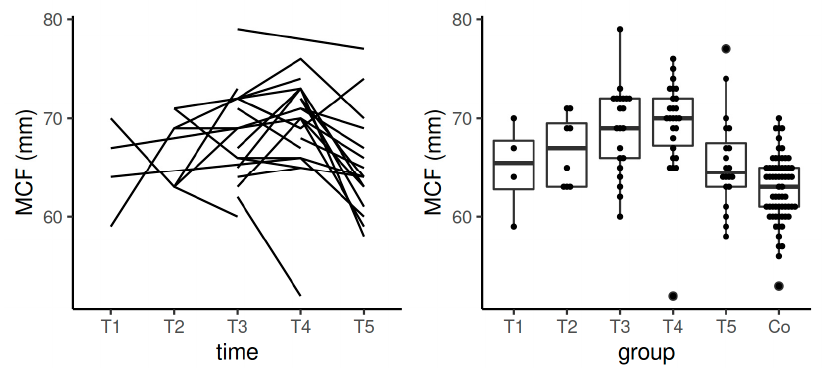
Figure 5. Spaghetti plot of the data from the longitudinal study (left), and swarmplot with boxplot the same data together with the data from the control group ( right )—the results of MCF in of the same data together with the data from the control group (right)—the results of MCF in EX- TEM. Legend: Co—control group, MCF—maximum clot firmness, T1—time interval 1, T2—time interval 2, T3—time interval 3, T4—time interval 4, T5—time interval 5.